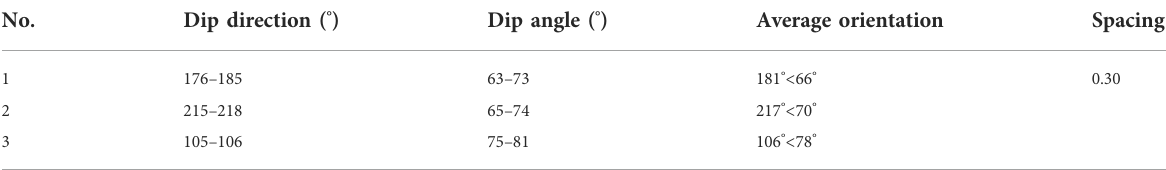
TABLE 1 Attitude of the major joints in the hanging wall.